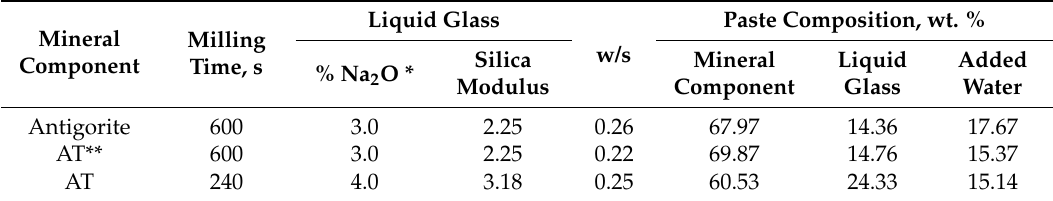
Table 2. Examples of mixture compositions.